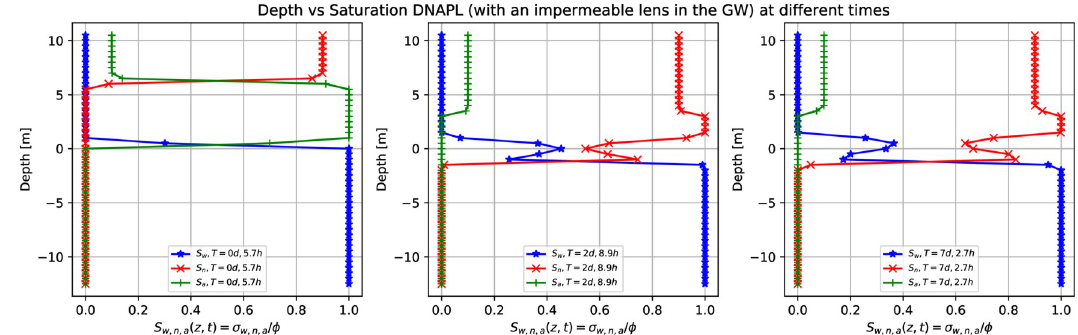
Fig 18. Depth vs. saturation of DNAPL (with an impermeable lens in the groundwater) at different times. Three-dimensional numerical simulation results of a depth as a function of the water saturation S w (blue points), DNAPL saturation S n (red points), and air saturation S (green points) at various times for a continuous leak of DNAPL of Fig 17 (plane x = 0). The continuous source of a DNAPL encounters an impermeable obstacle (depicted in green in Fig 17). Initially, the contaminant (red points) is situated on the parallelepiped (left-hand side). Then the sharp front starts to move downward (middle) until it arrives at the saturated zone where the impermeable obstacle causes the contaminant to accumulate just below the groundwater table (right-hand side).